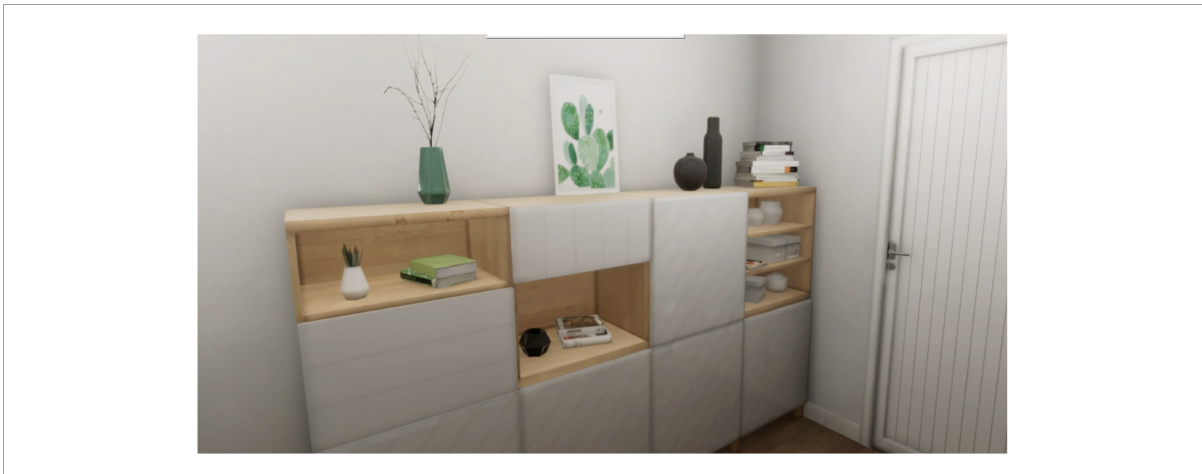
FIGURE3 Neutral